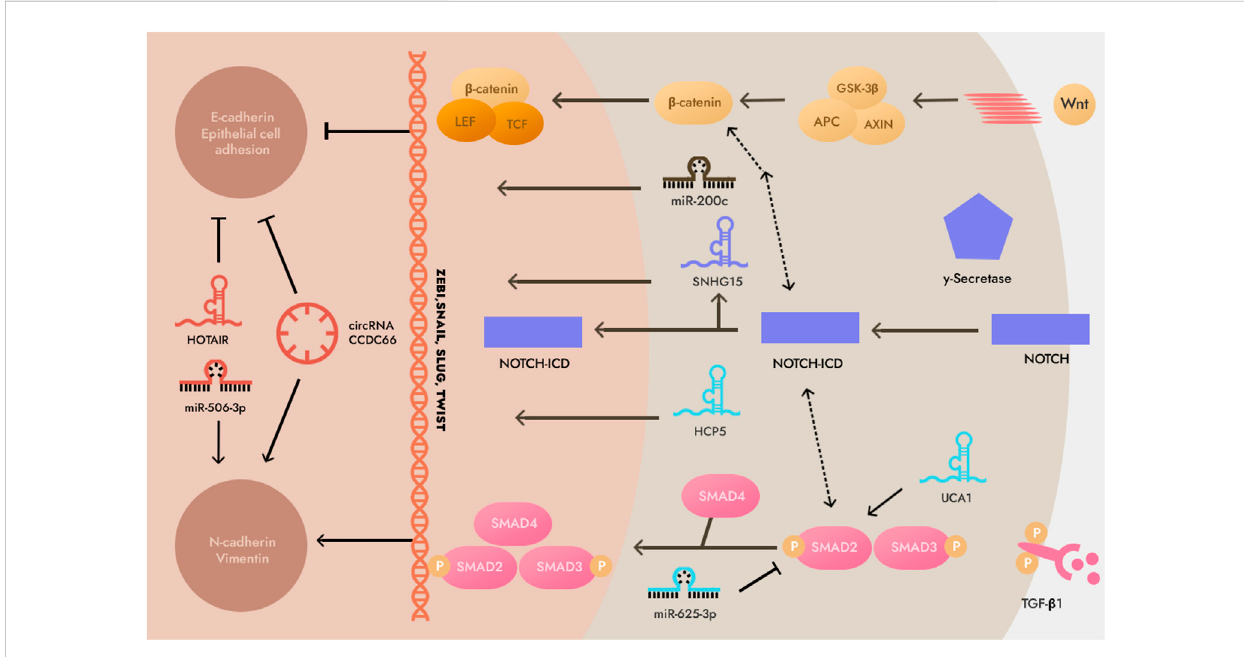
FIGURE 3 Non-coding RNAs (ncRNAs) involved in epithelial-mesenchymal transition (EMT). This illustration demonstrates that the EMT process is predominantly composed of transforming growth factor- β 1 (TGF- β ), WNT and neurogenic locus notch homolog protein (NOTCH) signaling